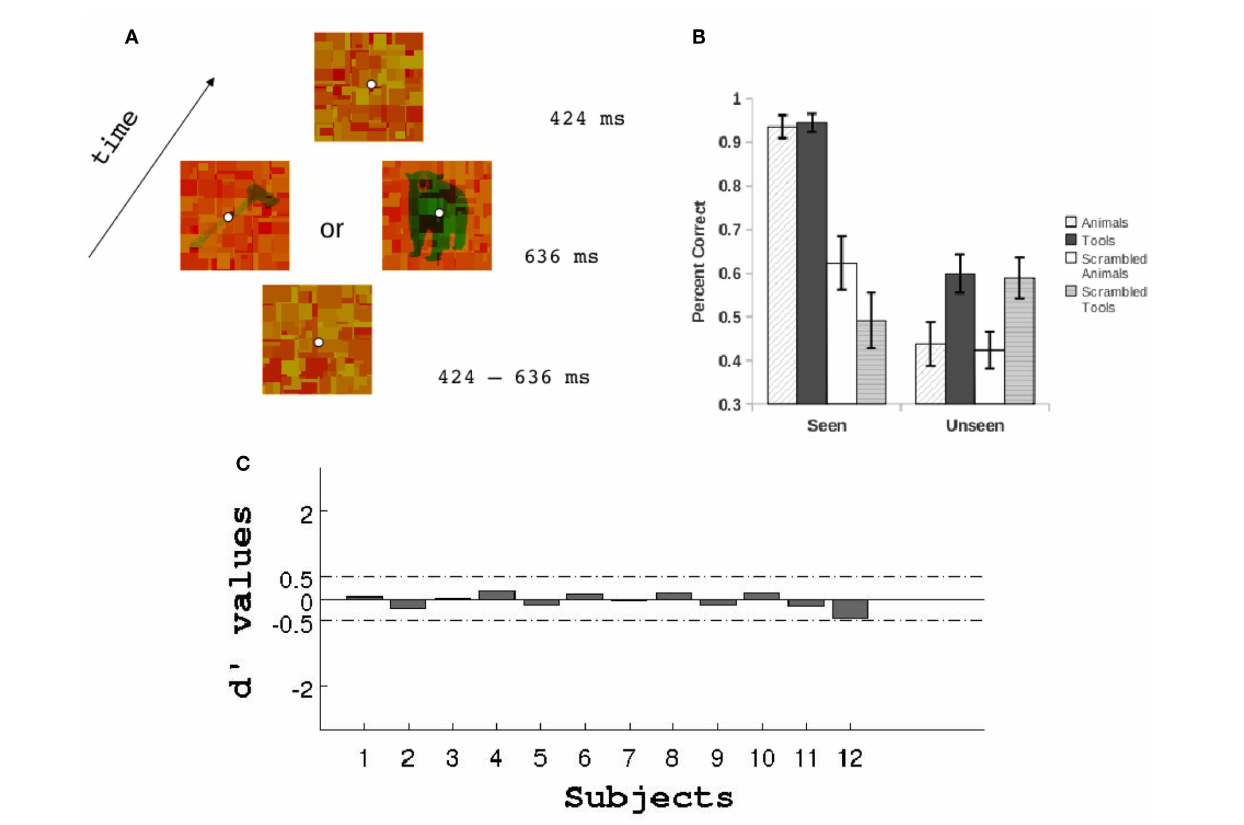
Materials and Methods). This task was identical to that depicted in (A) but with half the trials presenting a blank screen instead of a target. Subjects had to report whether they had seen a target or nothing. Signal detection theory was used to estimate for each subject the target luminance values that yielded a d’ between − 0.5 and 0.5. In addition to this objective measure of invisibility subjects reported to be completely unaware of any targets presented at low luminance